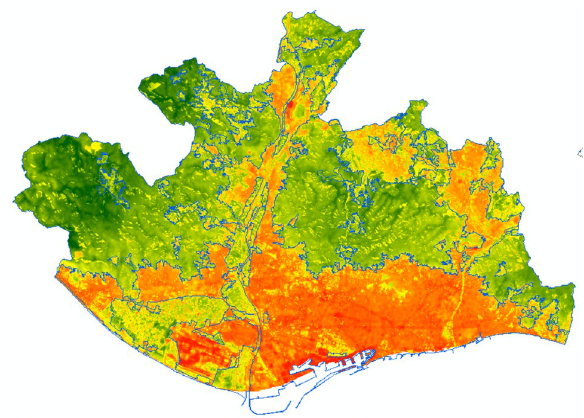
Figure 8. Nighttime LST (using winter NDVI) summer 2015 (blue line shows artificialized